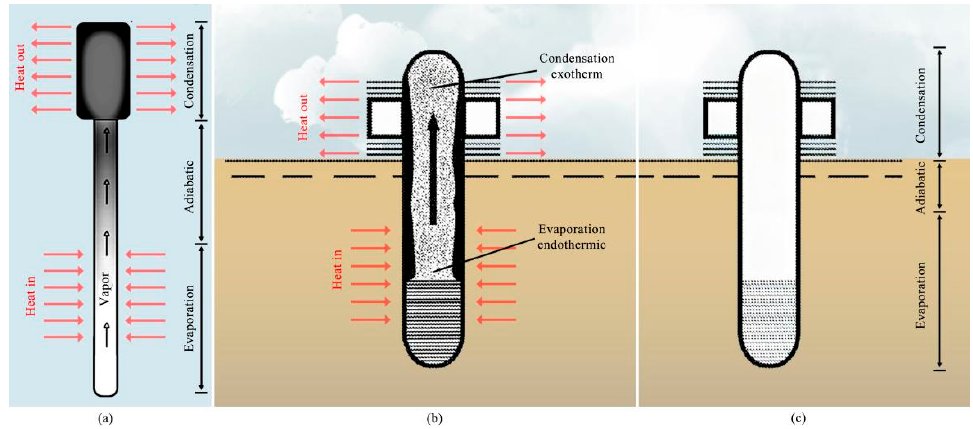
Figure 1. The working principle of heat pipe [35,36]: ( a ) heat pipe structure; ( b ) heat pipe start (cold season); ( c ) heat pipe dormancy (hot season).